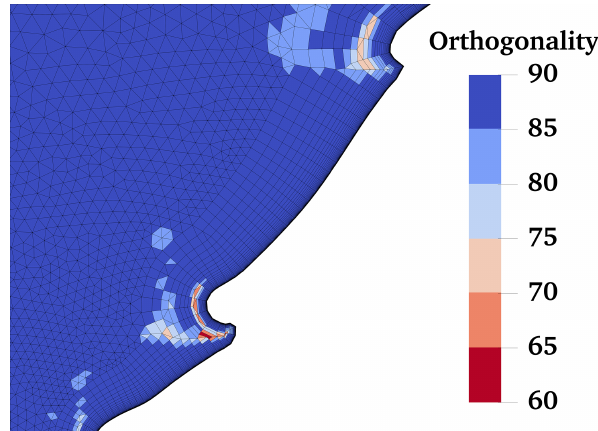
Figure 16. Detail of the computational grid on the final ice shape of Section B, showing the orthogonality of the grid. The region cor- responds to the red box shown in Fig.